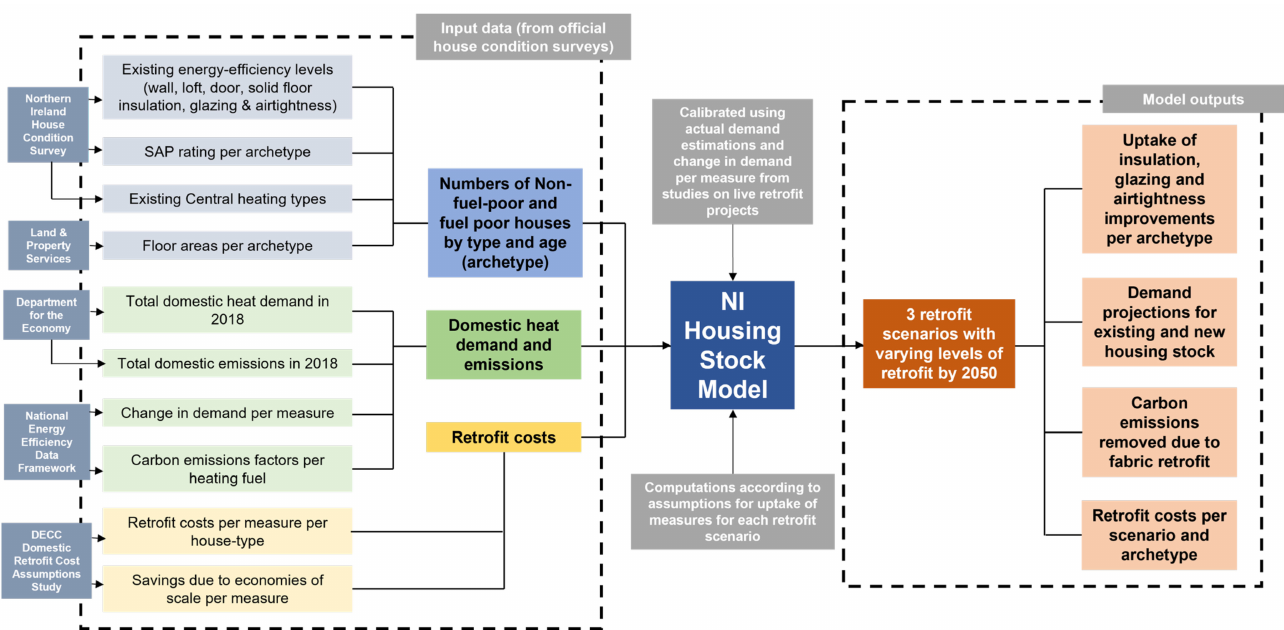
Figure 1. Diagrammatic description of this study’s